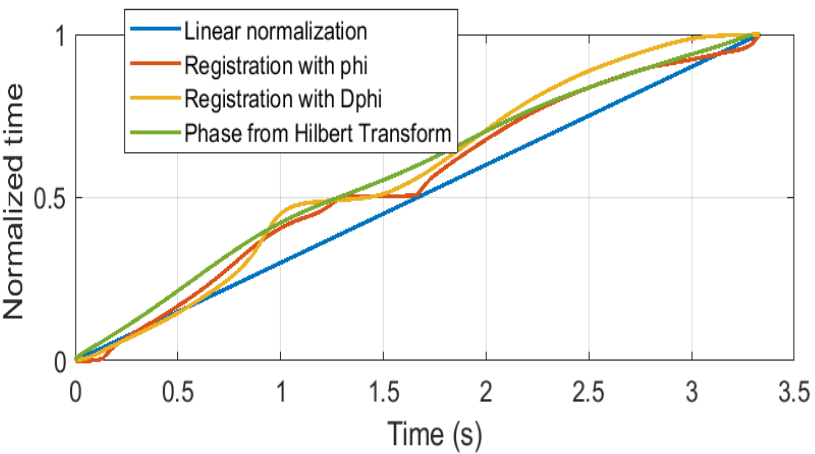
Figure 7. Comparison of the time warping functions for the four methods and registration curve number #345.